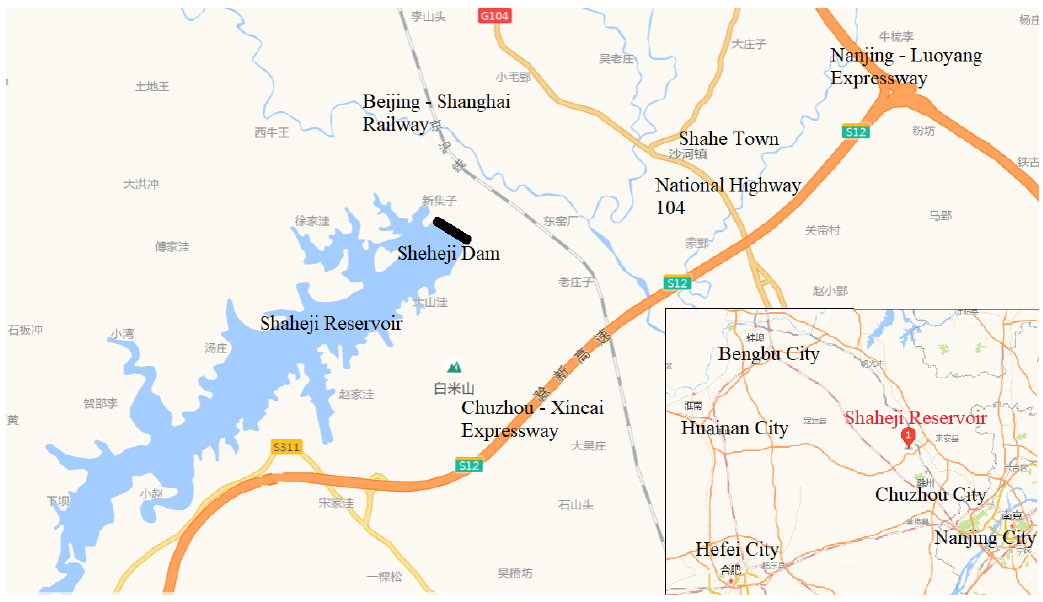
Figure 4. Location of Shaheji Reservoir.